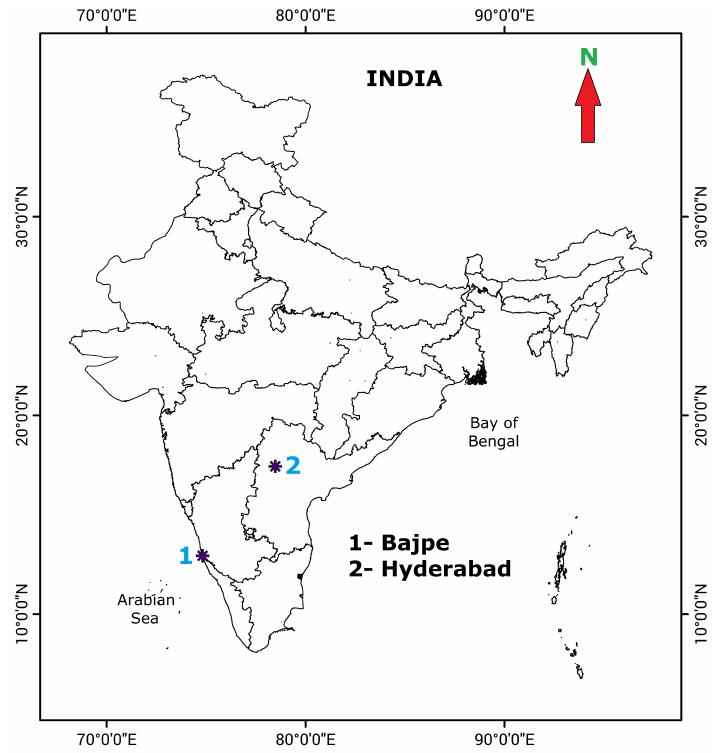
Figure 3. The coordinate of the inspected meteorological